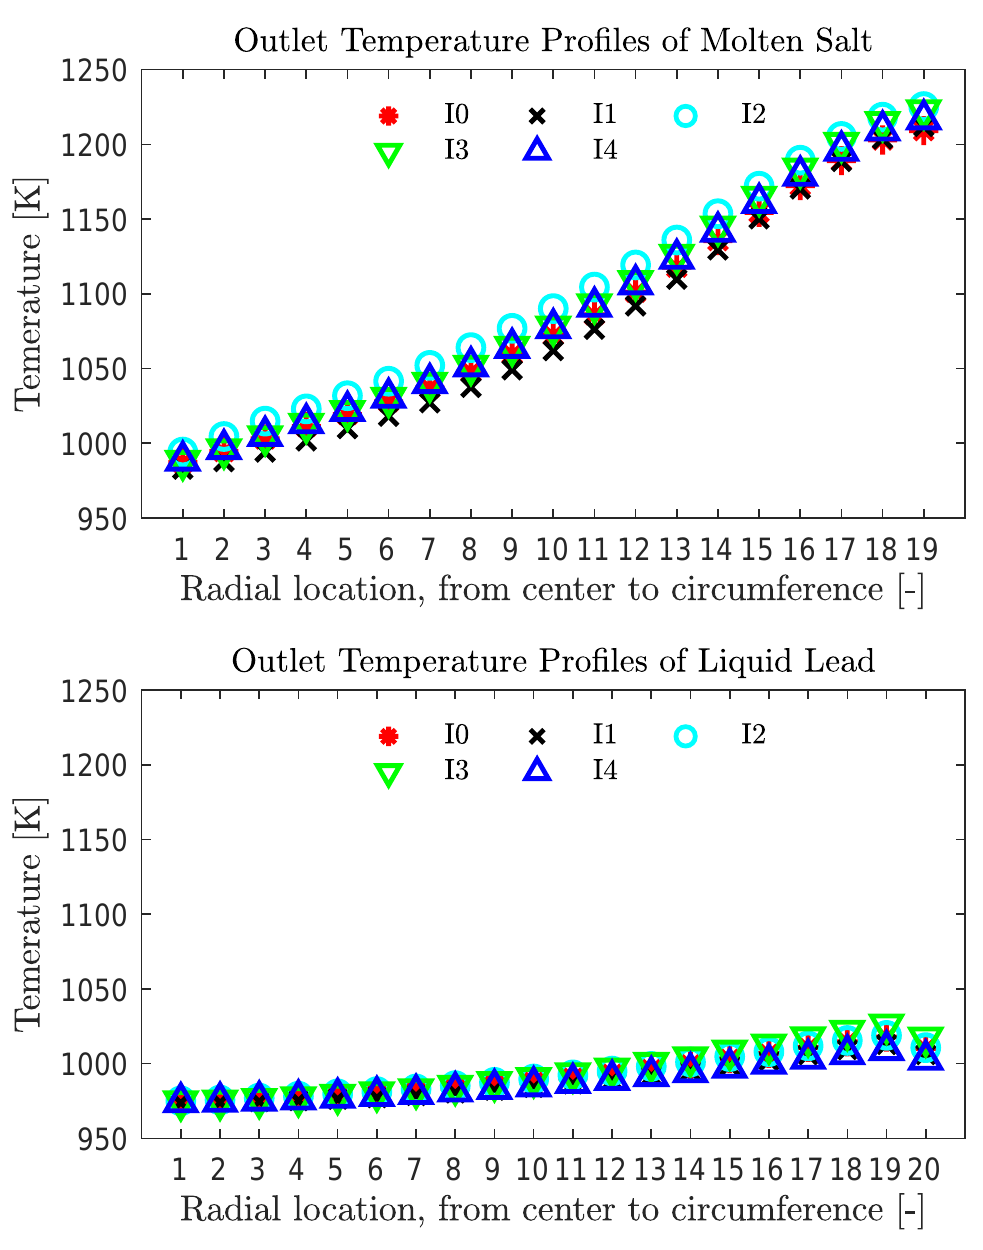
Figure 16. Outlet temperature distribution at various inlet scenarios: top, temperature profiles of molten salt; bottom, temperature profiles of liquid